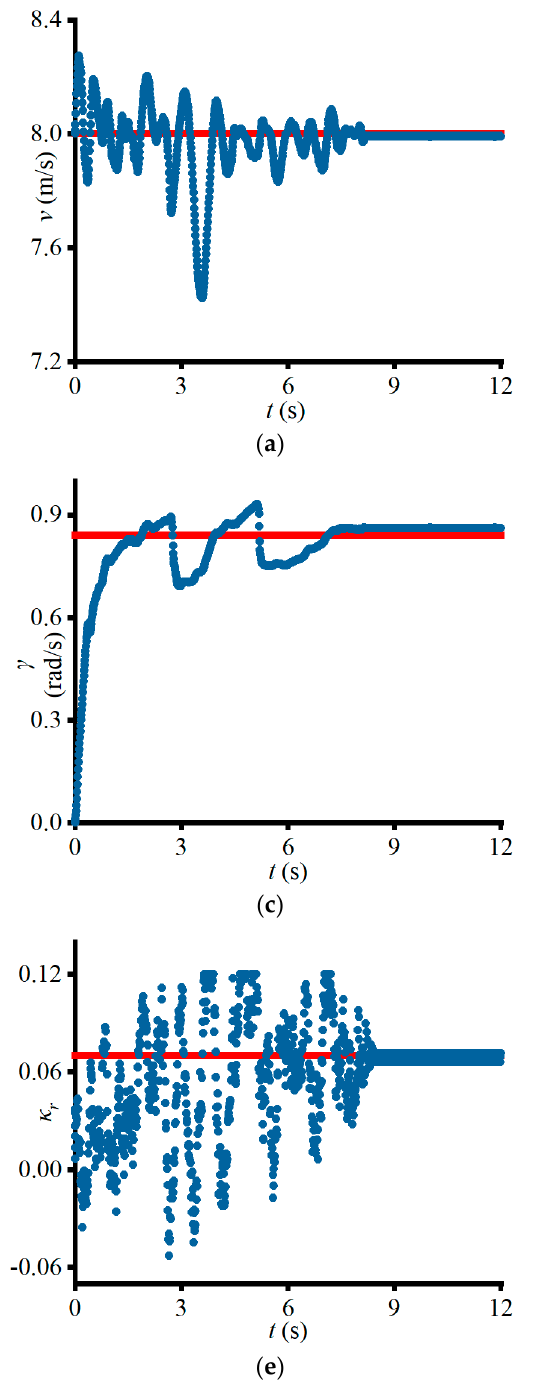
Figure 6. The simulation result of group (b) in Table 2 with the origin uniform linear: ( a ) the variation curve of the velocity; ( b ) the variation curve of the sideslip angle; ( c ) the variation curve of the yaw rate; ( d ) the variation curve of the steering angle; ( e ) the variation curve of the TYDEX longitudinal slip ratio of the rear tire; ( d ) the variation curve of the radius.